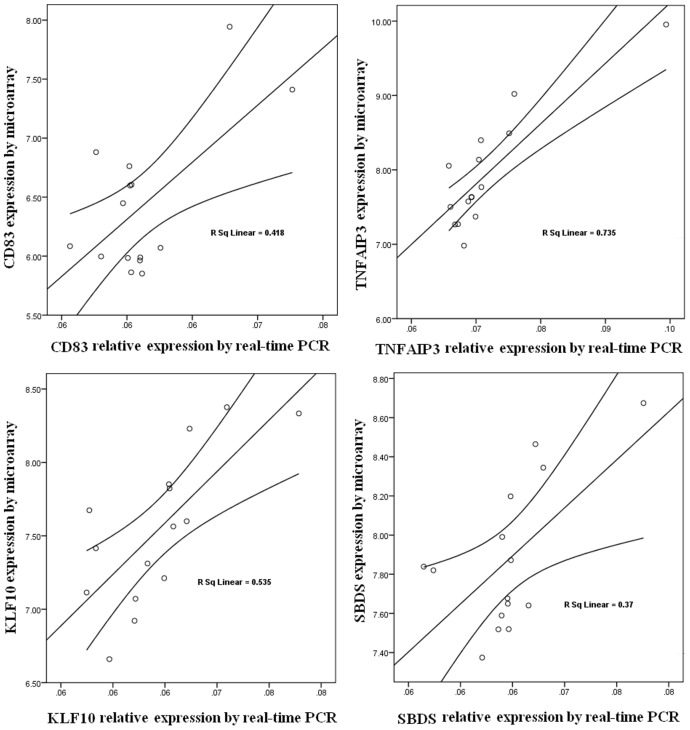
Verification of microarray gene expression by Real-time PCR.For verification of gene expression real-time PCR was performed for four genes including CD83, TNFAIP3, KLF10 and SBDS. Relationship between two sets of data from microarray and real-time PCR is shown by linear regression with 95% mean prediction interval. The results showed the relative expression of these genes was consistent with the expression observed from the broad gene expression by microarray.